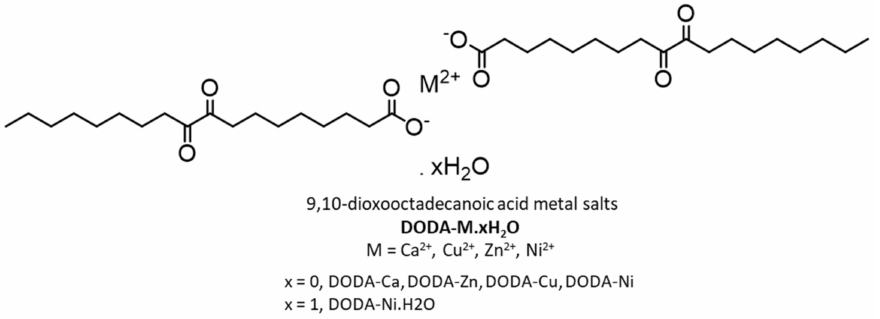
Figure 24. Structures of salts examined as metallo gelators derived from DODA. Republished from [91] with permission of The Royal Society of